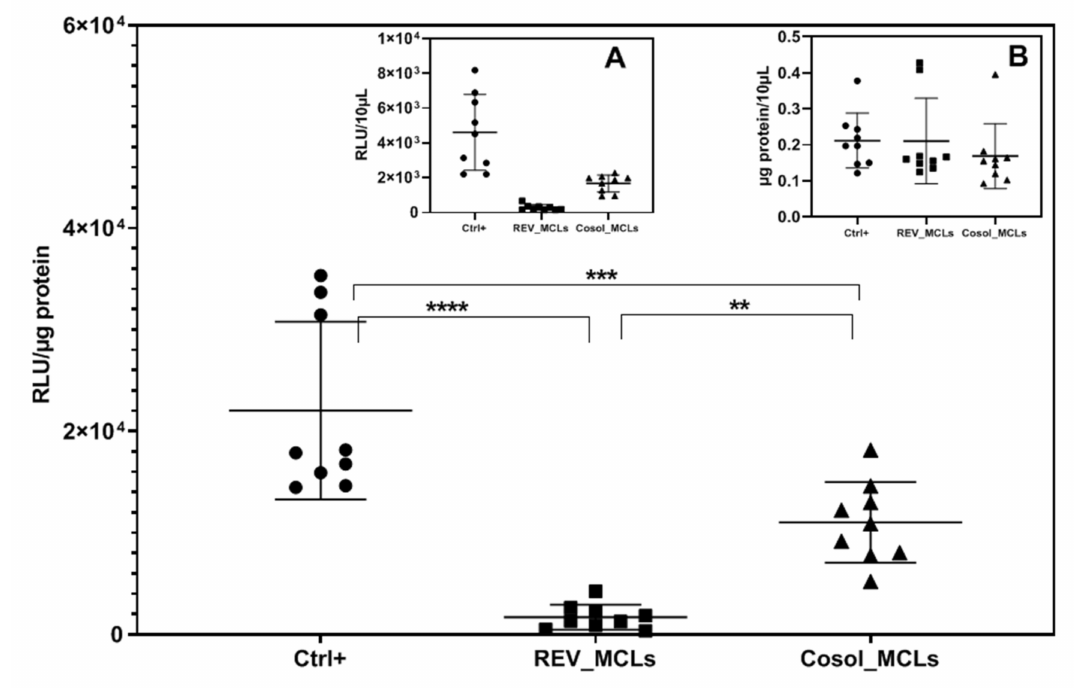
Figure 15. Transfection e ffi ciency of lipoplexes at RC8 in a CT26 cell line. Cells were seeded at 10 4 cells / well in a 96-well plate. Luciferase and protein assay were carried out 24 h after the incubation of cells with 100 µ L of lipoplexes containing 1 µ g of pFAR4-luc in the absence of a magnetic field for 3 h. Transfection e ffi ciency is calculated as RLU / µ g protein. The data given are averages of 3 di ff erent experiments, each performed in triplicate ( n = 9); bars, SD. One-way ANOVA was done with GraphPad Prism software, ** p ≤ 0.01, *** p ≤ 0.001, **** p ≤ 0.0001. Inserted figure: ( A ) RLU, ( B ) µ g protein in 10 µ L of cell lysis 24 h after incubation. RLU, relative light unit; RC = nmol DMAPAP / µ g pFAR4-luc. Ctrl + (dark circle): positive control (lipoplexes based on liposome DOPE / DMAPAP / C14PEG1000 49:50:1 mol / mol); REV_MCLs (dark square): lipoplexes based on REV_MCLs; cosol_MCLs (dark triangle): lipoplexes based on cosols